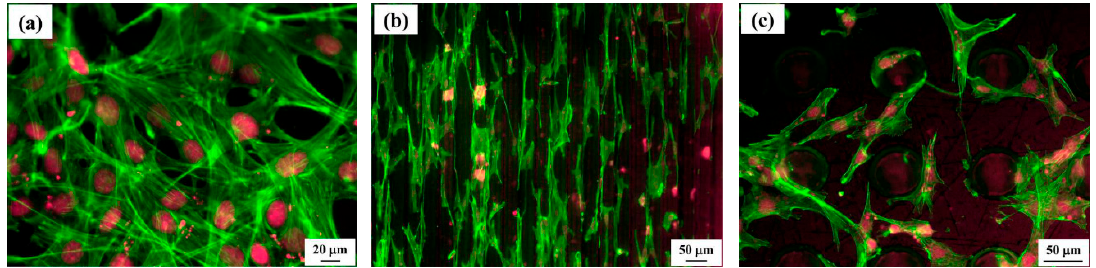
Figure 11. Micrographs of ( a ) as received and laser surface textured with ( b ) line geometry and ( c ) dimple geometry showing the attachment of MC3T3-E1 mouse fibroblast cell on the surface [83]. Reprinted with permission from reference [83] 2015 Elsevier.